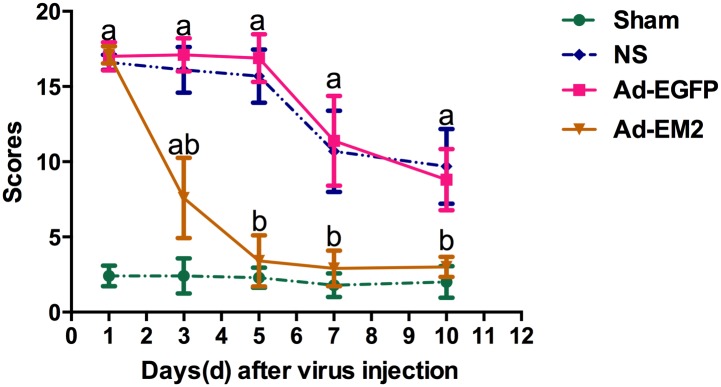
Total score of morphine withdrawal symptoms.On the 3rd, 5th, 7th, and 10th day after intrathecal injection, withdrawal scores were decreased markedly in the Ad-EM2 group compared to that in the Ad-EGFPand NS groups (bP<0.0001). Endomorphin-2 was indicated as EM2; adenovirus with EM2 was indicated as Ad-EM2; adenovirus with enhanced green fluorescence protein was indicated as Ad-EGFP; normal saline group with subcutaneous morphine injection and intrathecal NS administration was indicated as NS; Sham group with subcutaneous NS injection and intrathecal NS administration was indicated as Sham.